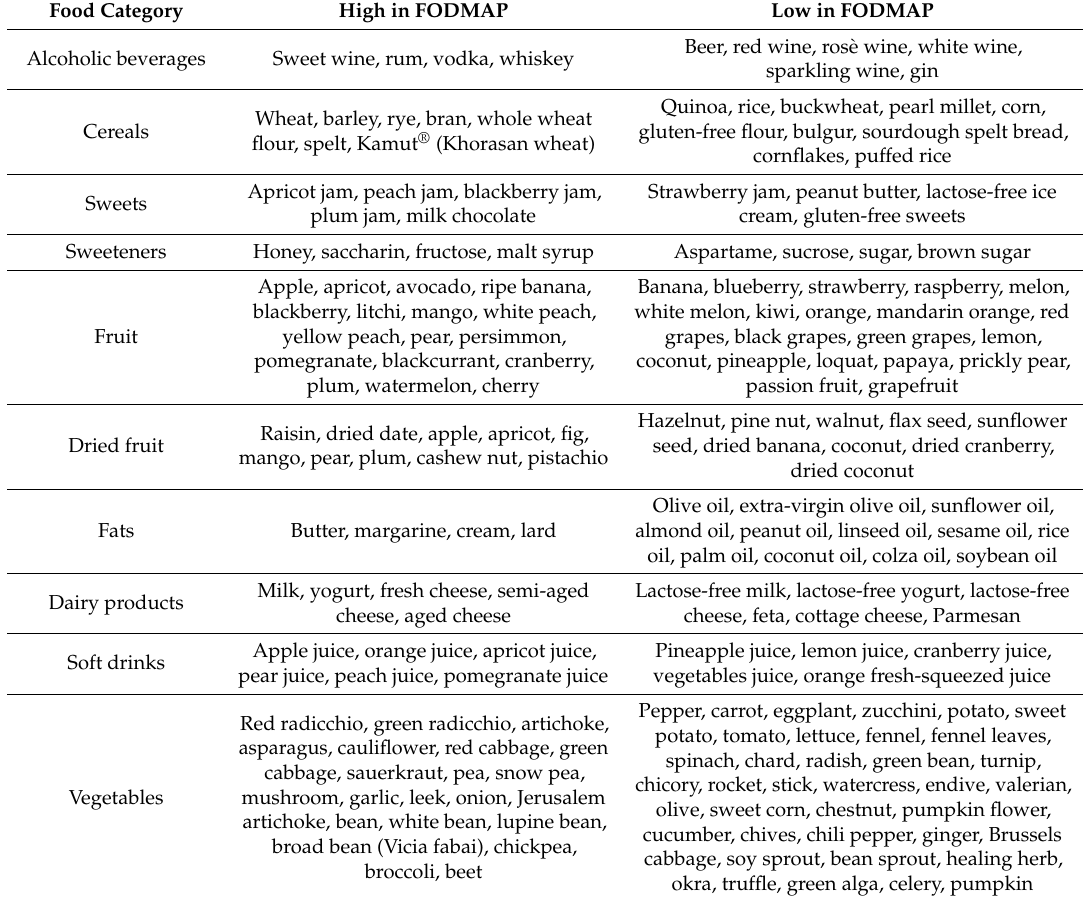
Table 1. Foods with high and low amounts of FODMAP †